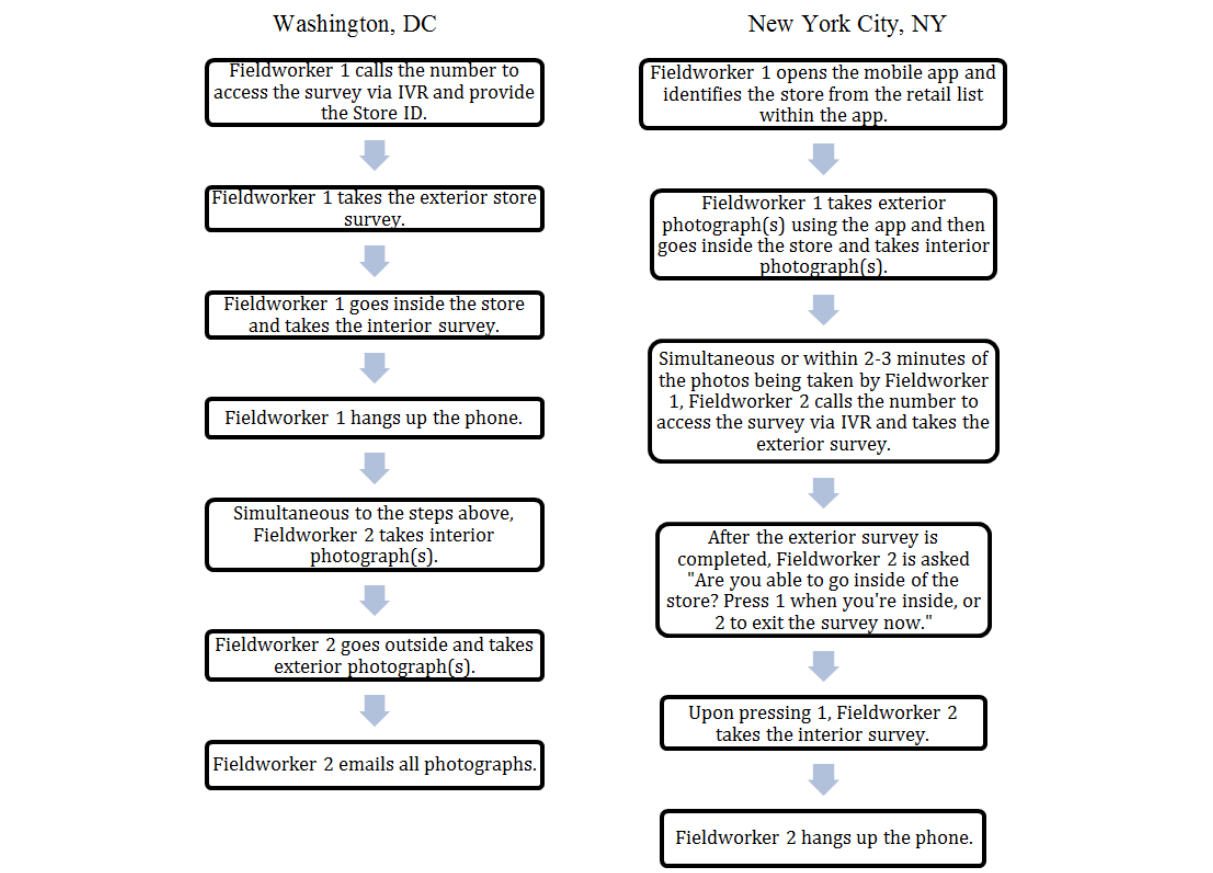
Figure 1. Final optimized workflow for DC and